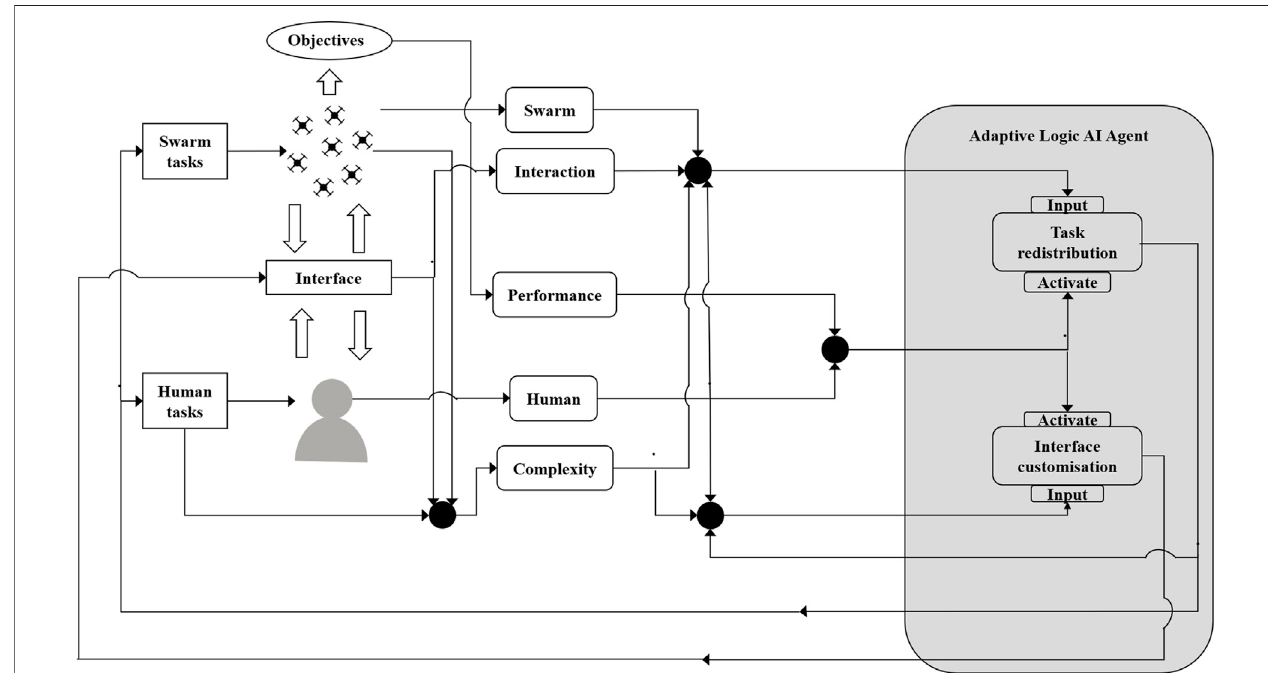
FIGURE 1 | Framework for adaptive autonomy in